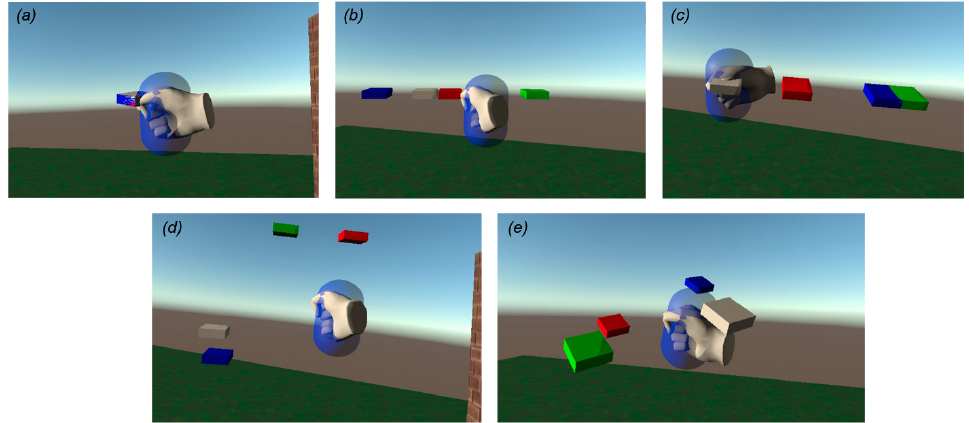
Figure 2. The different layouts that can be used for displaying the multiple objects that are grasped: ( a ) same position, ( b ) line, ( c ) forearm, ( d ) fan, ( e )